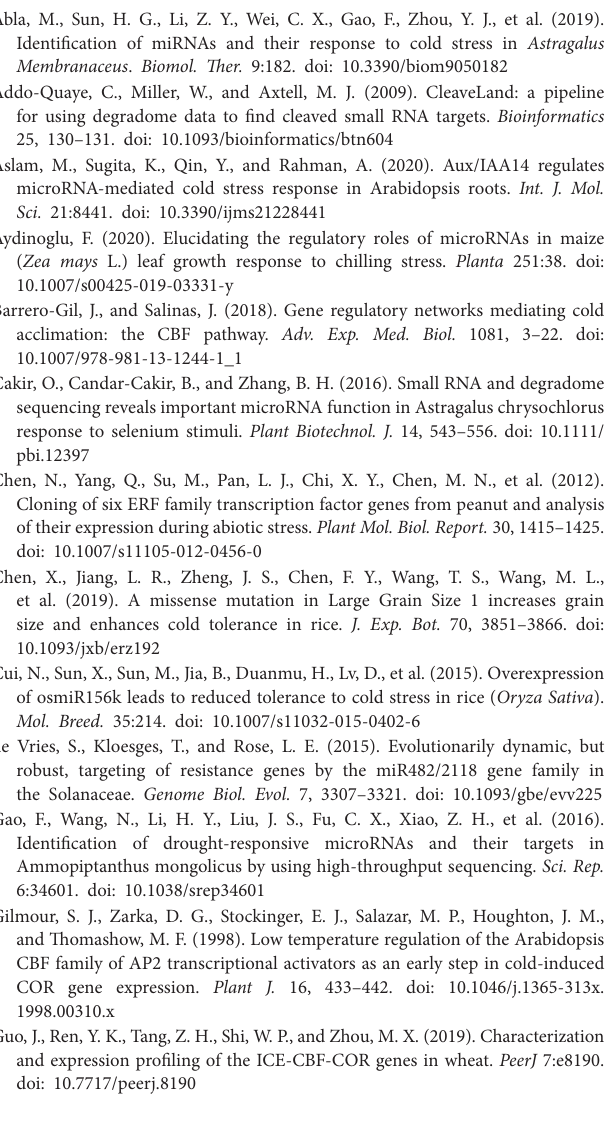
distribution of the degradome tags along the full length of the target mRNA sequence. The vertical red line indicates the cleavage site of each transcript and is also shown by an arrow. (A,D) The cleavage features in AhWDRL1 (Arahy. C265D9.1) and AhWDRL2 (Arahy.ER1LI4.1) mRNA by ahy-miR482 in DS2. (B,E) The cleavage features in AhSRF (Arahy.XK3KPA.1) and AhSP1L1 (Arahy. NV23DS.1) mRNA by ahy-miR1511 in DS2. (C,F) The cleavage features in Supplementary Table S1 | List of identified miRNAs differentially expressed in peanut with cold treatment. Supplementary Table S2 | Statistics of degradome reads in DS1 and DS2. Supplementary Table S3 | Differentially-expressed target genes between the DS1 and DS2 libraries. Supplementary Table S4 | Primer